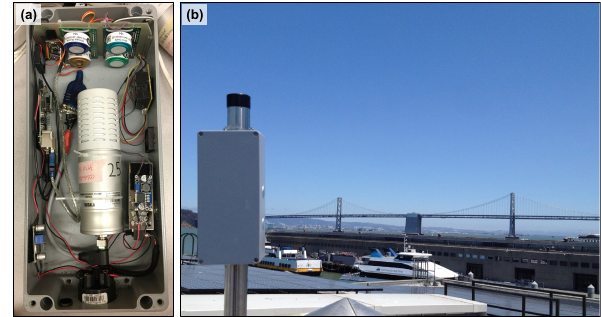
Figure 2. (a) Current BEACO 2 N node design and (b) a photo of a node